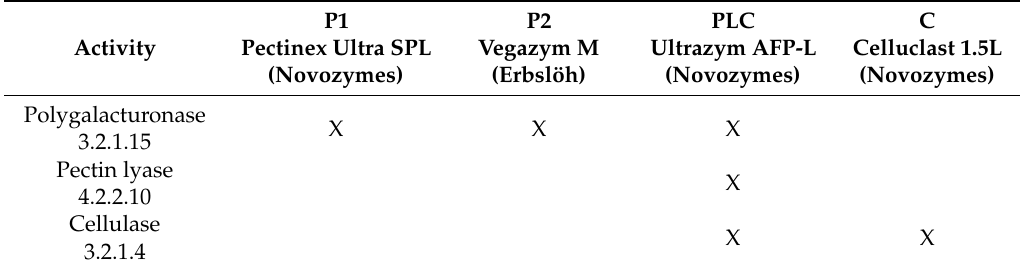
Table 1. Commercial enzyme preparations (manufacturers in brackets) and its declared activities.